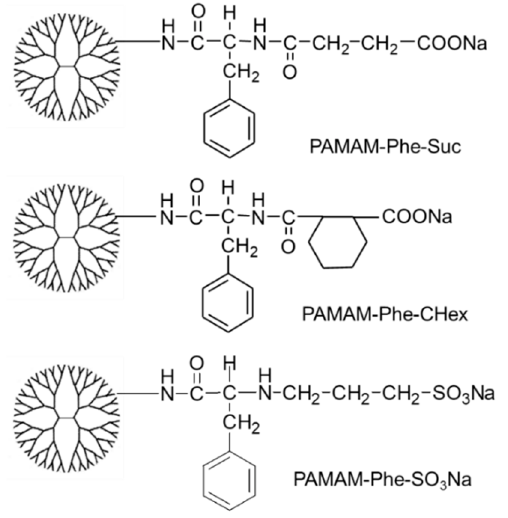
Figure 1. Dendrimer structures of PAMAM-Phe-Suc, PAMAM-Phe-CHex and PAMAM-Phe-SO 3 Na.